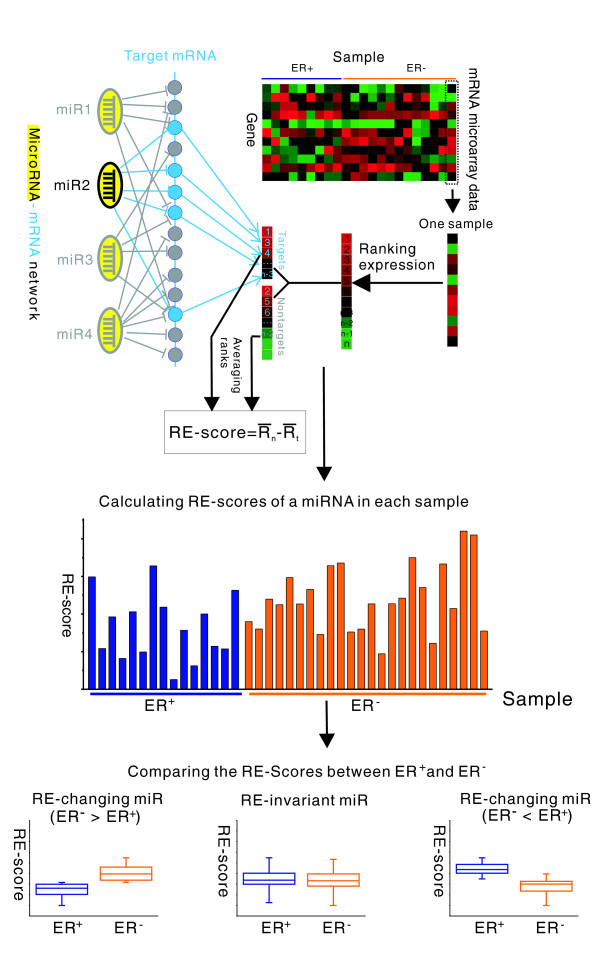
Schematic diagram showing the method for identifying RE-changing miRNAs between ER- and ER+ breast cancer samples. For each miRNA in each sample, a RE-score is calculated by comparing average ranks of its target and non-target genes. RE-changing miR (ER- > ER+) and RE-changing miR (ER- < ER+) represent miRNAs that have significantly higher and lower RE-scores in ER- compared to ER+ samples, respectively. RE-invariant miR represents miRNAs that show no significant difference in RE-scores between these samples. Note that many miRNAs share the same target mRNA, while many mRNAs can also be targeted by the same miRNA, which constitutes a complex miRNA-mRNA network.